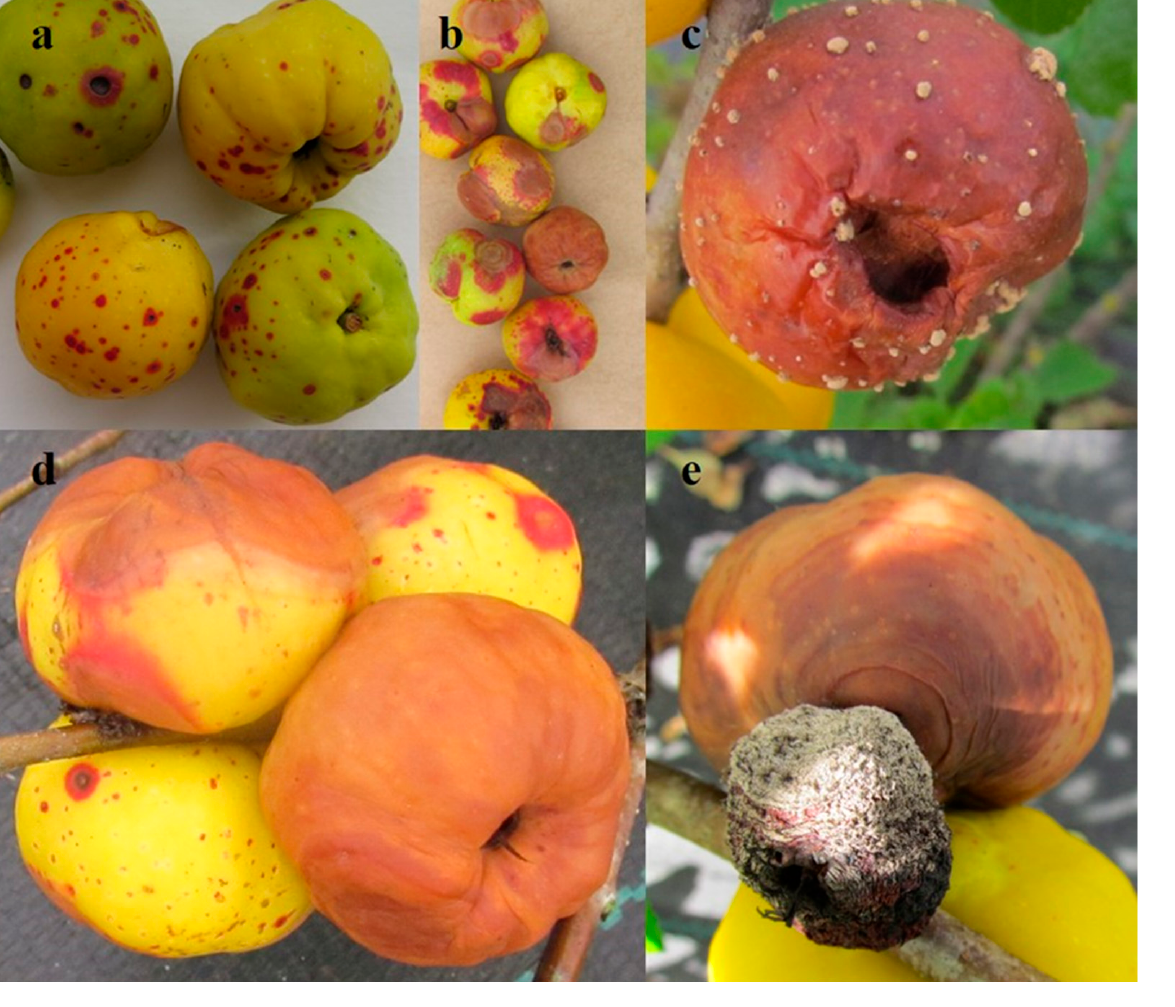
Figure 2 . Damage to Japanese quince fruits: ( a )—fruit spots; ( b – e ): various symptoms of fruit rot. Areas of detected shoot damage were round or oval with dead, sunken, or cracked bark (Figure 3b–d). We also observed that the bark of the damaged shoots peeled off from the damaged areas (Figure